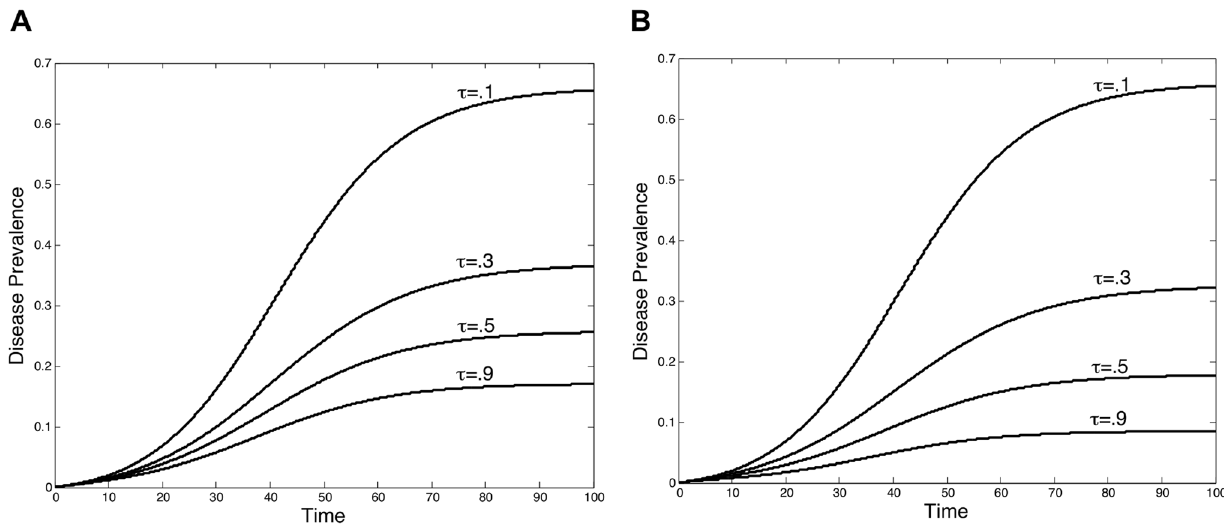
Figure 4. Disease prevalence with different levels of treatment efficacy. When treatment efficacy increases, some of the decrease in disease prevalence is lost due to a decline in screening. Figure A depicts the prevalence corresponding to the equilibrium levels of screening provided in Figure 3. While prevalence decreases with the increase in treatment efficacy, it does not decline by as much as it would have if screening did not decline as well. In Figure B, disease prevalence is shown for each level of treatment efficacy if institutions were to screen at the higher screening level associated with the equilibrium for t ~ : 1 , depicted in Figure 3. doi:10.1371/journal.pcbi.1003407.g004 Figure 3 where the equilibrium screening level systematically decreases as treatment efficacy increases from t ~ : 1 to t ~ : 9 .